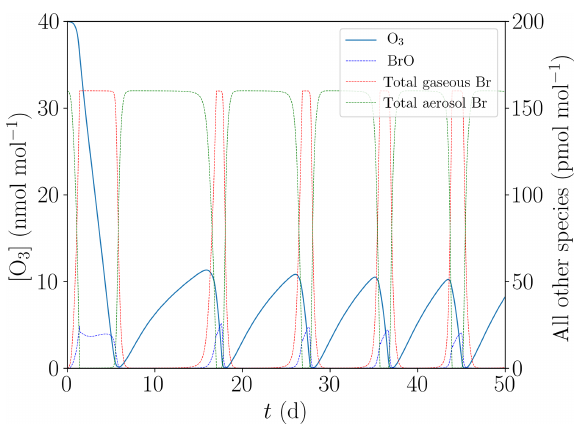
Figure 8. Simulation neglecting the snowpack and the exchange between the boundary and the inversion